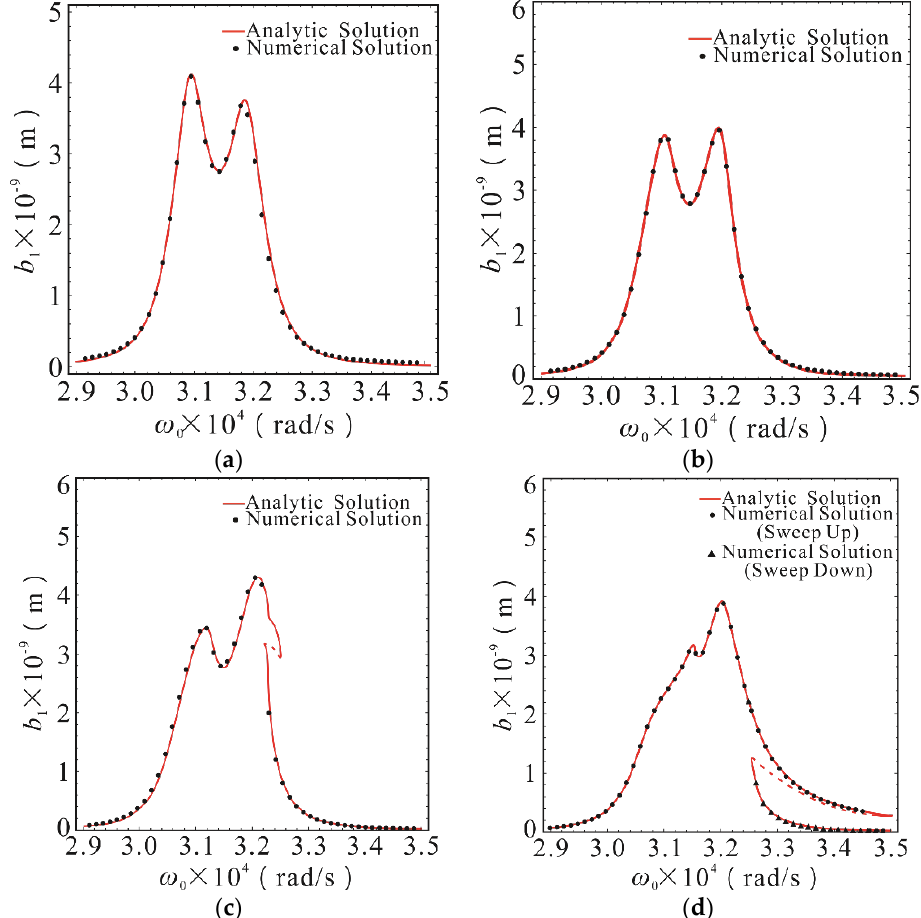
Figure 5. The amplitude-frequency response curves of first-order sense mode with different stiffness nonlinear coefficients in the case of σ 2 = 5.91 × 10 7 . ( a ) The case of K 1 = K 2 = 0; ( b ) The case of K 1 = K 2 = 10 11 N/m 3 ; ( c ) The case of K 1 = K 2 = 10 11.5 N/m 3 ; ( d ) The case of K 1 = K 2 = 10 12 N/m 3 . The point was calculated using the Runge-Kutta method. The line was calculated using the MMS. The solid lines represent the stable solution. The dashed lines represent the unstable solution.